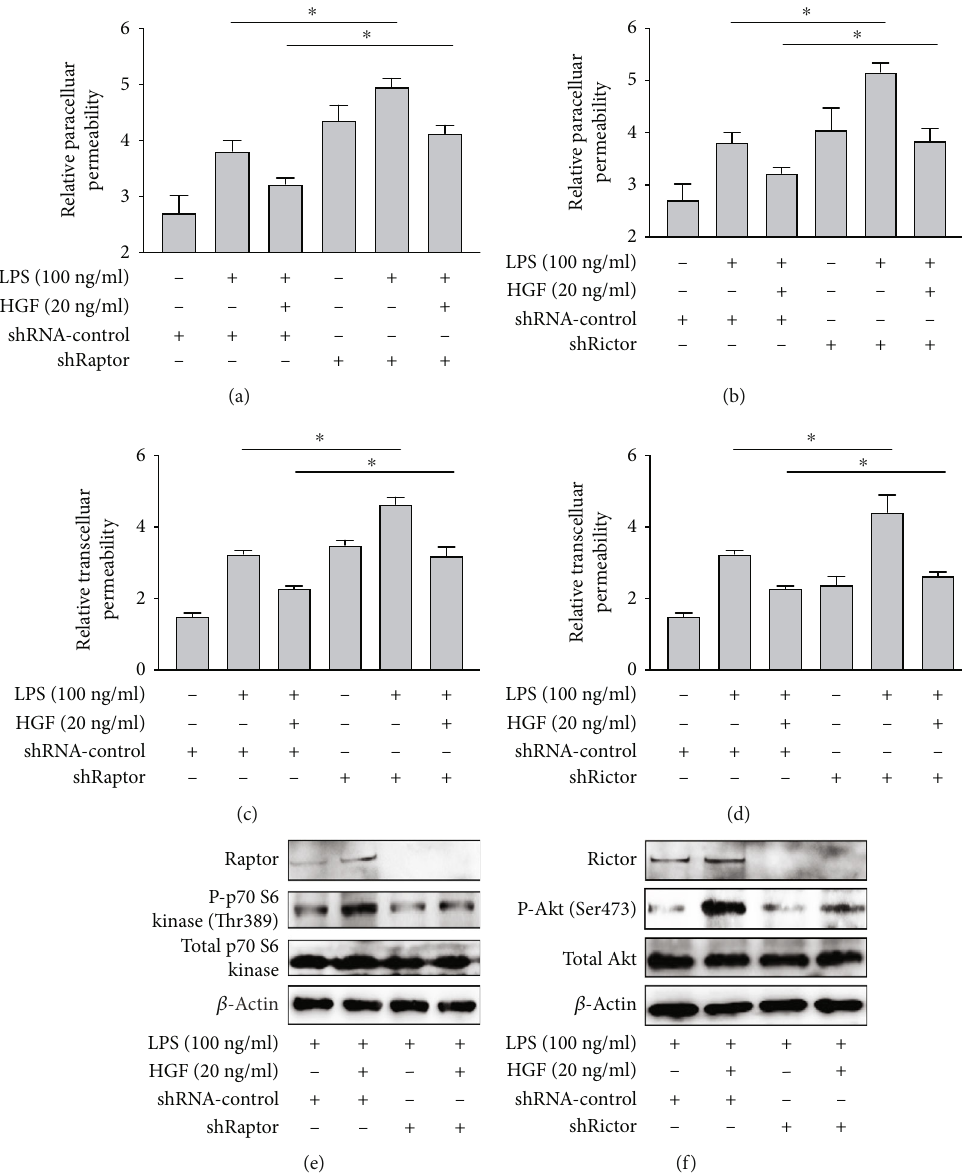
Figure 4: E ff ects of mTORC1 and mTORC2 to HGF on endothelial permeability in LPS-induced PMVECs. Lentivirus vector-mediated mTORC1 (raptor) and mTORC2 (rictor) knockdown in PMVECs (shRaptor and shRictor as knockdown, shRNA-control as negative control) was conducted. PMVECs were treated with HGF (20 ng/ml), with or without stimulation with LPS (100ng/ml) for 24h. (a) The e ff ects of mTORC1 to relative paracellular permeability of HGF on LPS-induced PMVEC permeability with Alexa Fluor 647-dextran. (b) The e ff ects of mTORC2 to relative paracellular permeability of HGF on LPS-induced PMVEC permeability with Alexa Fluor 647- dextran. (c) The e ff ects of mTORC1 to relative transcellular permeability of HGF on LPS-induced PMVEC permeability with Alexa Fluor 647-BSA. (d) The e ff ects of mTORC2 to relative transcellular permeability of HGF on LPS-induced PMVEC permeability with Alexa Fluor 647-BSA. (e) Evaluation of HGF on mTORC1 signaling pathway for western blot. (f) Evaluation of HGF on mTORC2 signaling pathway for western blot. Results are mean ± SD ( n = 3 ). ∗ p < 0 : 05